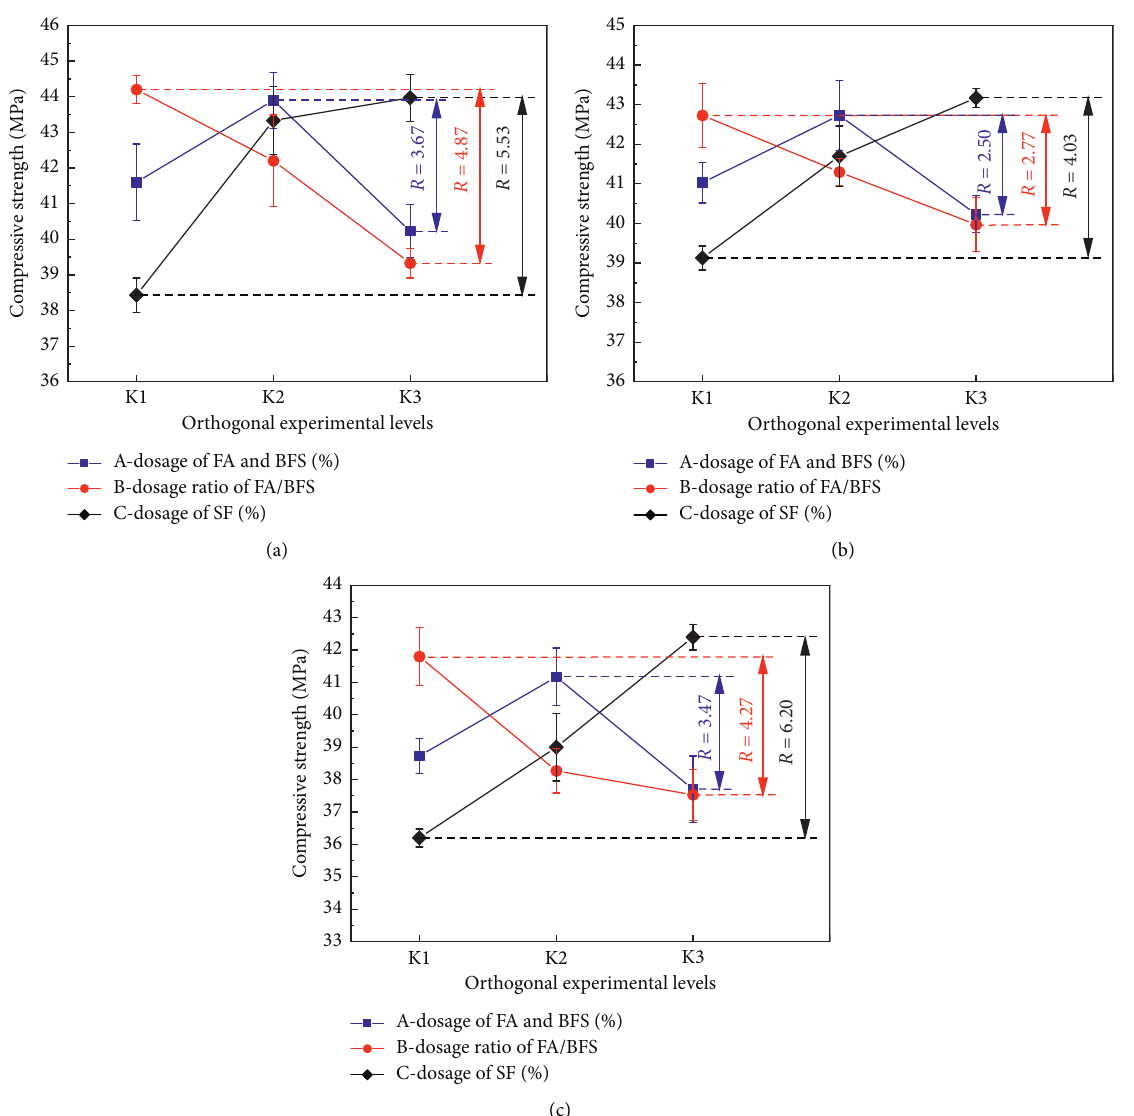
Figure 5: Range analysis between compressive strength and orthogonal experimental levels of cement concrete. (a) Air content of (2.5 ± 0.5)%. (b) Air content of (4.5 ± 0.5)%. (c) Air content of (6.5 ± 0.5)%.